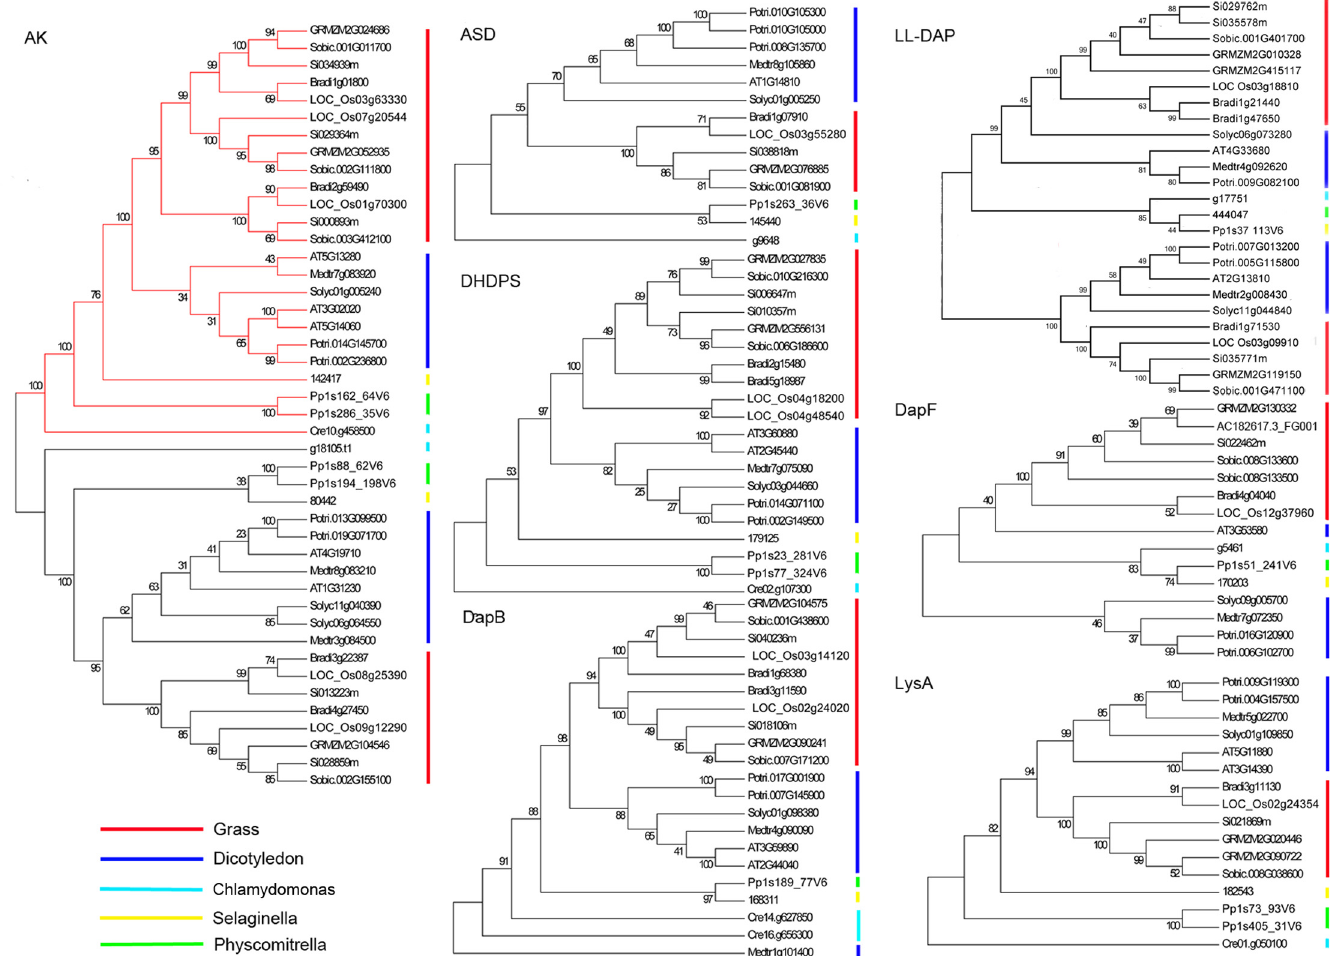
Fig 1. Phylogenetic trees of lysine biosynthesis pathway gene orthologs. Phylogenetic trees based on AK (aspartate kinase), ASD (aspartate- semialdehyde dehydrogenase), DHDPS (dihydrodipicolinate synthase), DapB (dihydrodipicolinate reductase), LL-DAP-AT (LL-diaminopimelate aminotransferase), DapF (diaminopimelate epimerase), and LysA (diaminopimelate decarboxylase) are shown. The AK tree contains two enzymes: the monofunctional enzyme AK (EC: 2.7.2.4; red branch) and the bifunctional enzyme HSDH (EC: 1.1.1.3; black branch)